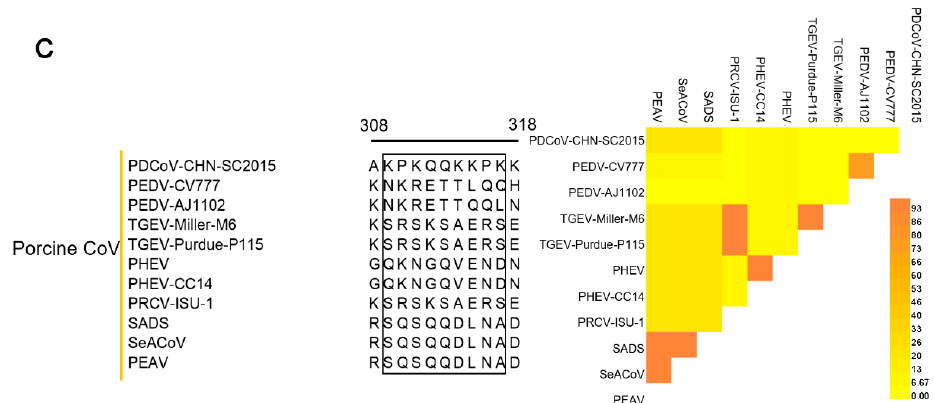
Figure 6. Comparison of the 4E88 epitope amino acid sequence among different virus strains. ( A ) EP-4E88 sequences from strains of PDCoV. Heat map of homology comparison between PDCoV CHN-SC2015 strain and other 24 PDCoV reference strains in GenBank. The sequences of EP-4E88 for all strains are surrounded by black frames; ( B ) EP-4E88 sequences from strains of other 15 deltacoronaviruses. Heat map of homology comparison between PDCoV CHN-SC2015 strain and 15 deltacoronavirus strains in GenBank; ( C ) EP-4E88 sequences from strains of other 11 porcine coronavirus. Heat map of homology comparison between PDCoV CHN-SC2015 strain and 11 porcine coronavirus reference strains in GenBank. The level of homology were analyzed by MAFFT v7.037 and analyzed by DNASTAR.